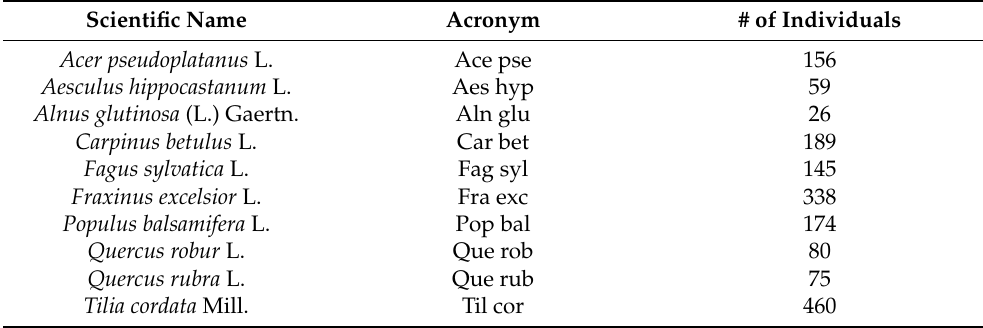
Table 1. Available number of individuals per tree species to analyze effects on measured surface temperatures.